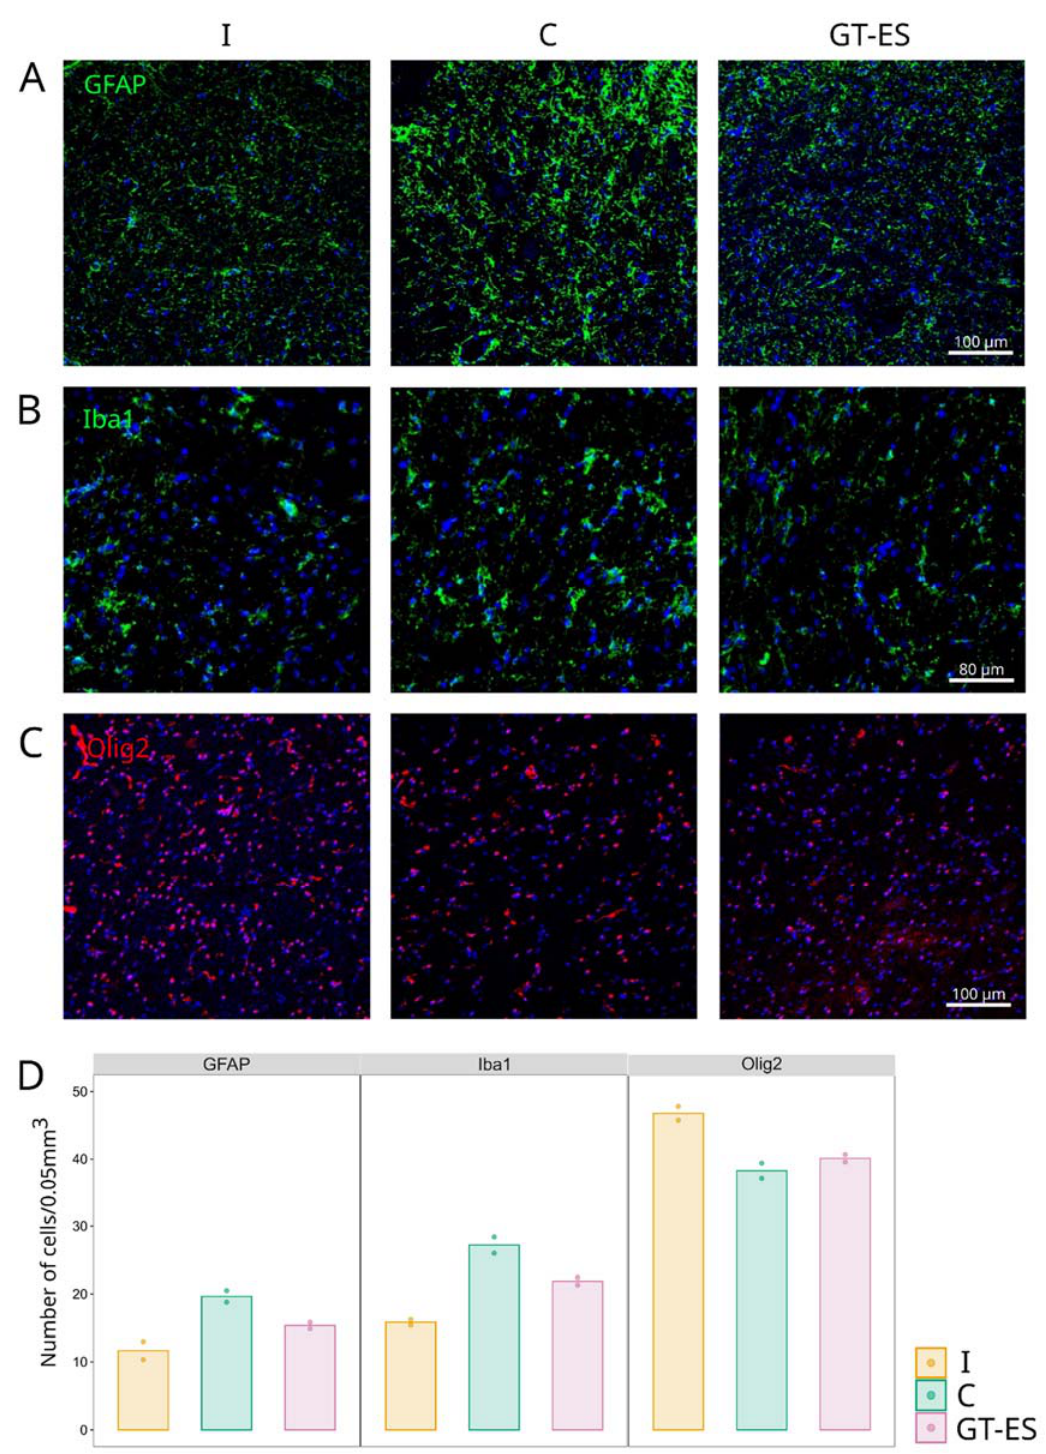
Figure 7. Immunofluorescent analysis of glial cells reorganization in spinal cord ventral horns at 60 days after SCI. ( A ) Astrocytes were visualized with antibodies against glial fibrilar acidic proteins (GFAP). ( B ) Microglial cells against ionized calcium binding adaptor molecule 1 (Iba1). ( C ) Oligodendroglial cell against transcription factor Olig2. Nuclei were counterstained with DAPI (blue). ( D ) Mean number of cells in intact (I), control (C), and treated (GT-ES) pigs. Values averaged within animals are presented as points; bars represent group-wise average values.